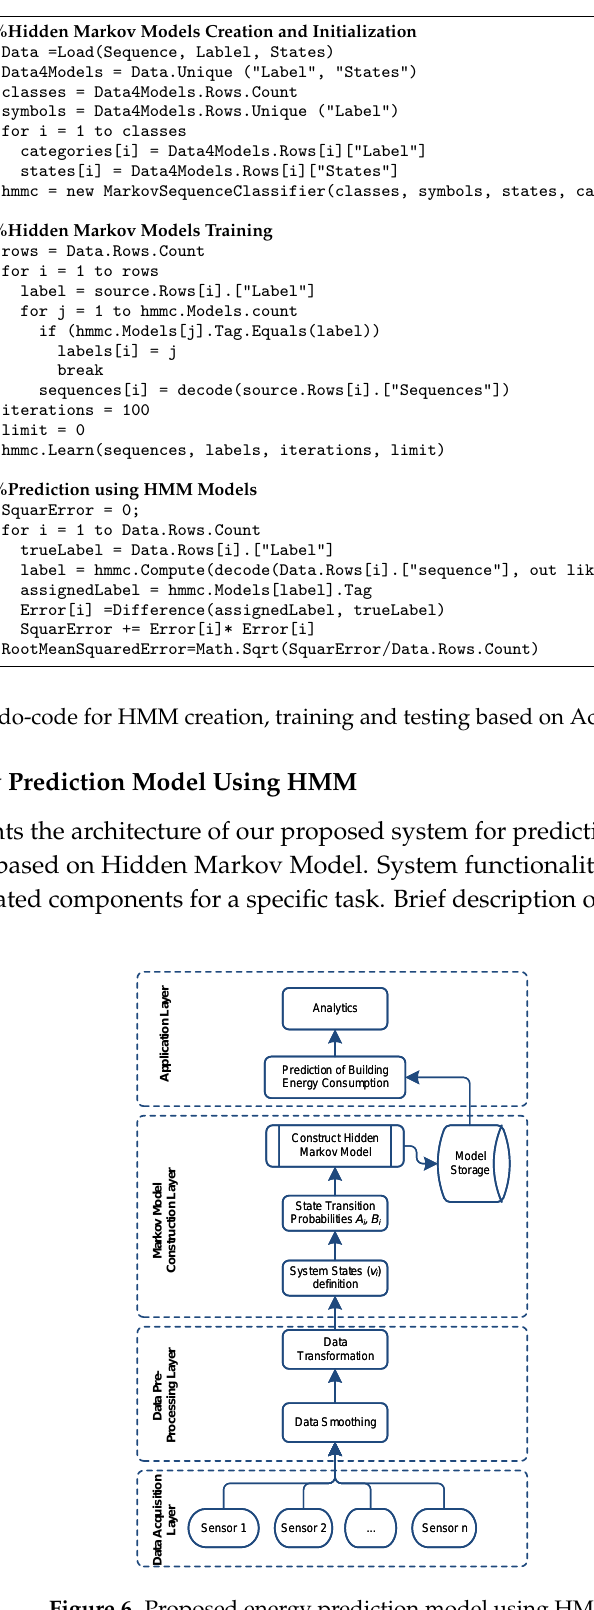
Figure 6. Proposed energy prediction model using